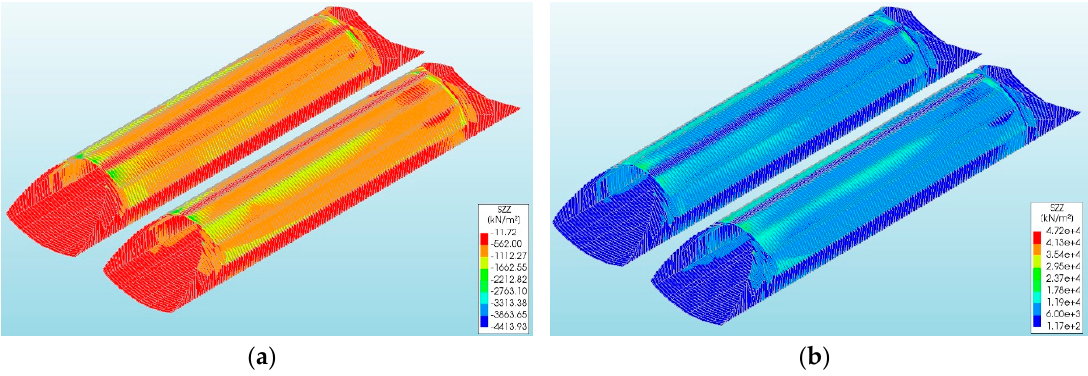
Figure 8. Maximal values of stresses of: ( a ) Rockburst for model Ia, ( b ) El Centro for model Ib.